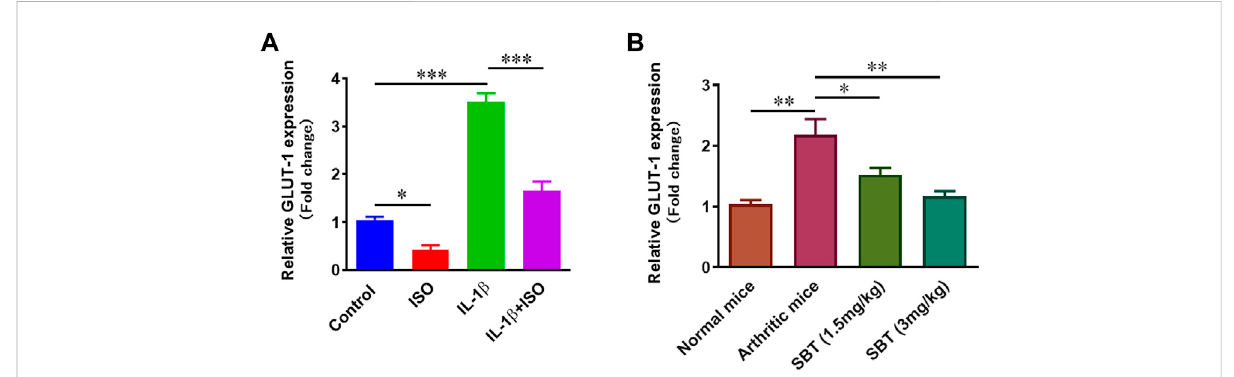
FIGURE 6 GLUT-1 geneexpressionanalysis invitro and invivo . (A) CHON-001cells weretreated withISO(10 − 5 mol/L), IL-1 β (10 ng/ml)orcombinationof both for 24 h. GLUT-1 gene expression was analyzed by using qPCR technique. (B) Articular chondrocytes were isolated from each experimental mice group at day 28 and qPCR was performed to analyze the gene expression of GLUT-1 . GAPDH was used as a reference. All experiments were performed in duplicates. Signi fi cance of data was measured by using One Way ANOVA. * p < 0.05, ** p < 0.01, *** p < 0.001.